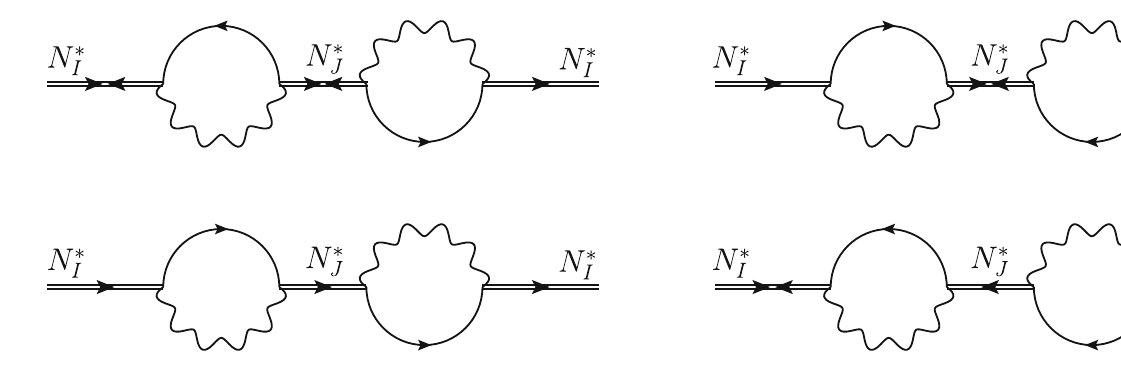
Fig. 5 Self-energy diagrams for the I th composite Majorana neutrino. Theimaginaryparts,namelythecuttingthroughleptonandgaugeboson lines, corresponds to the interference of tree-level and one-loop self- Fig. 3 may be computed from the imaginary part of the